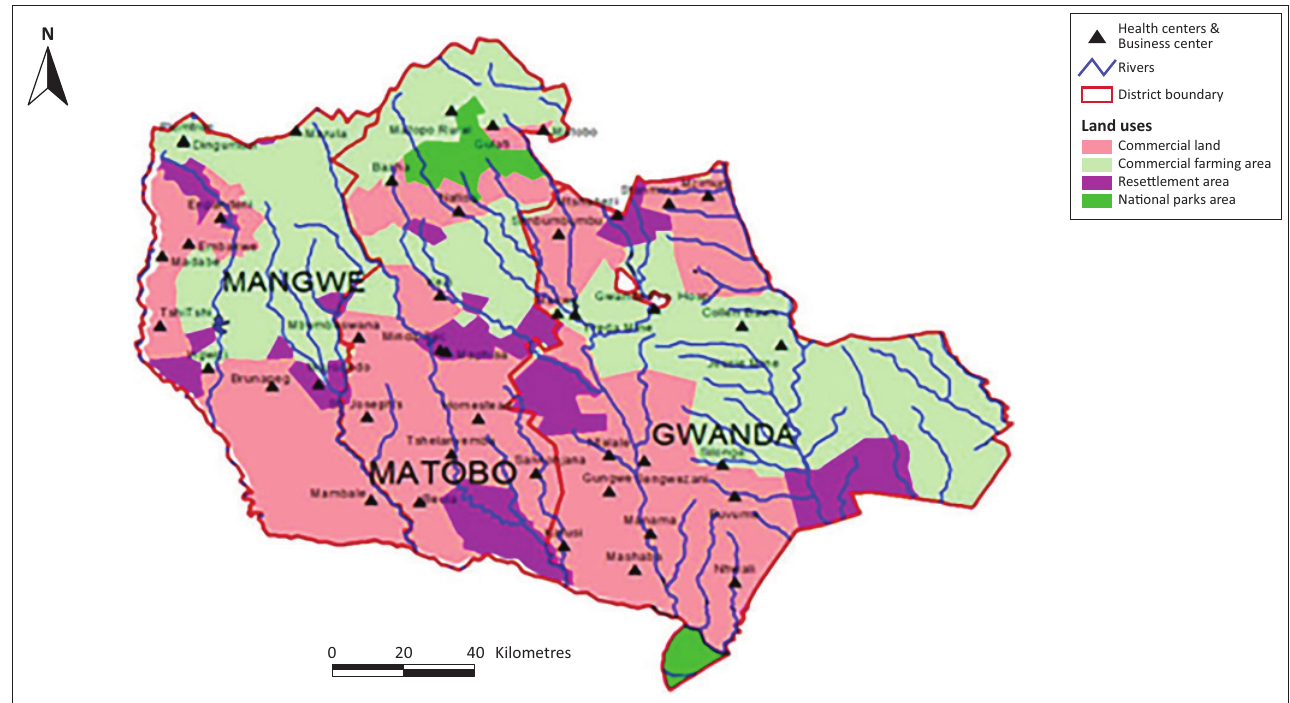
FIGURE 1: The map of Matabeleland South showing Mangwe, Matobo and Gwanda